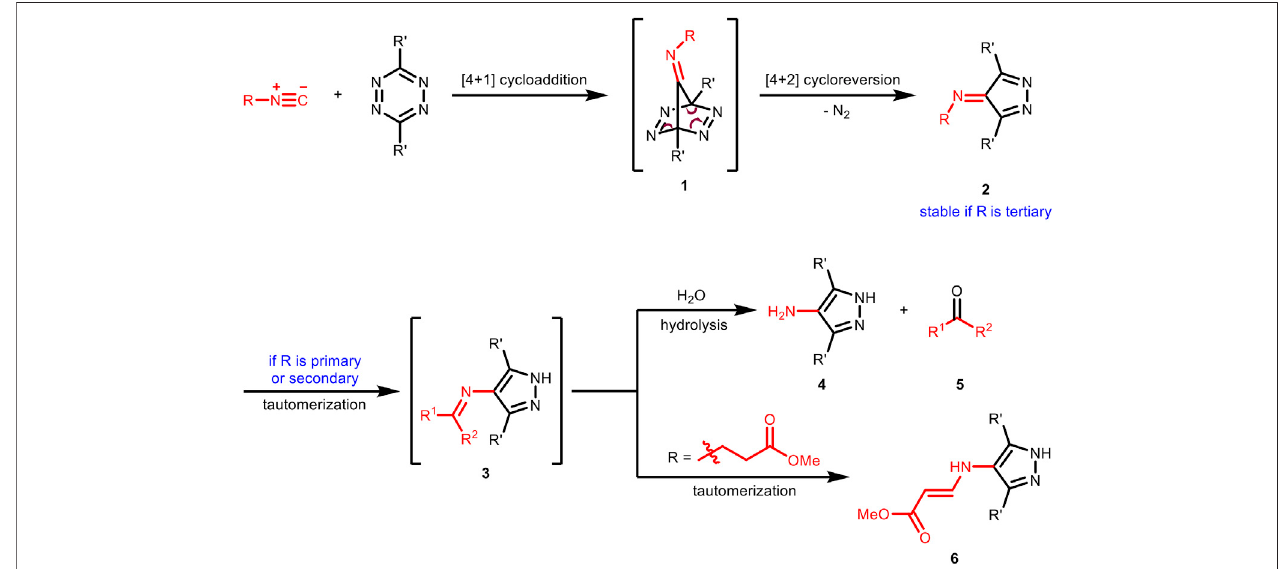
FIGURE 2 | Mechanism of the reaction between isocyanides and tetrazines.